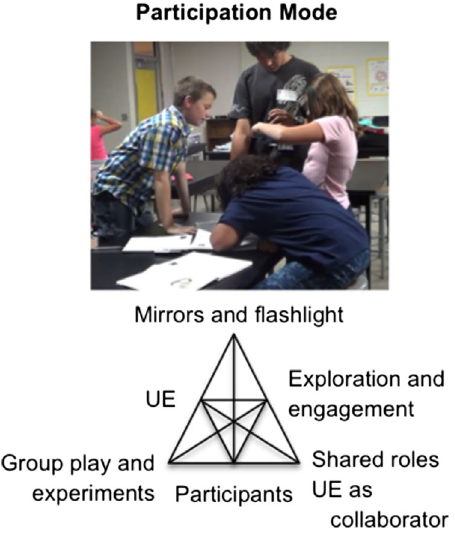
FIG. 4. Participation mode. Photo (top) shows Mateo interact- ing with students in his group during PISEC. They are working on an activity reflecting light off of mirrors. The triangle (bottom) shows the interconnected aspects of the system with Mateo as the